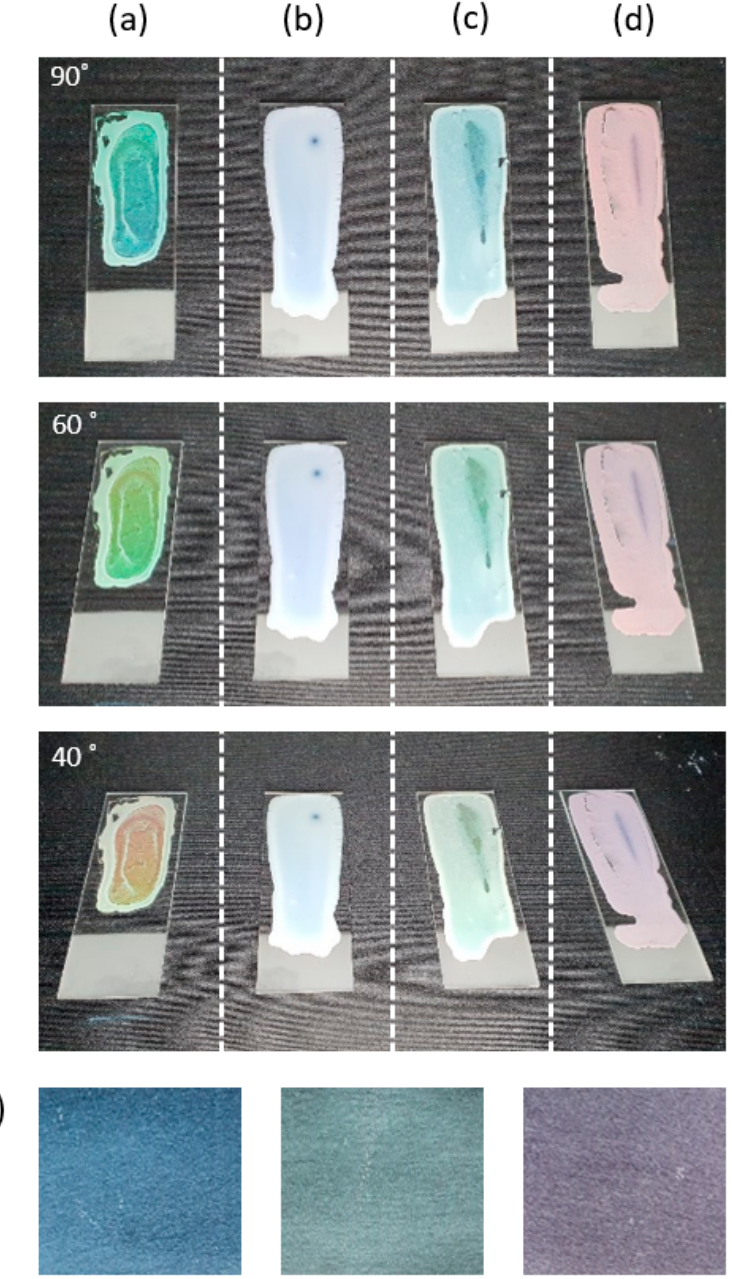
Figure 8. Photographs of the silica solution coatings under three viewing angles: ( a ) Case 1 (various colors depending on angles); ( b ) Case 2 (blue); ( c ) Case 3 (green); ( d ) Case 4 (red); ( e ) Colored membranes consist of solely of spherical silica particles.